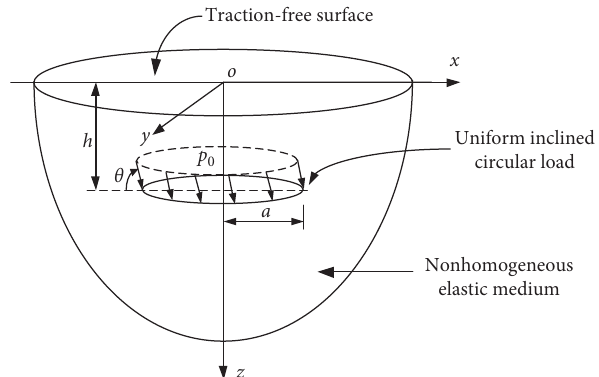
Figure 1: Inclined load at the interior of a nonhomogeneous elastic